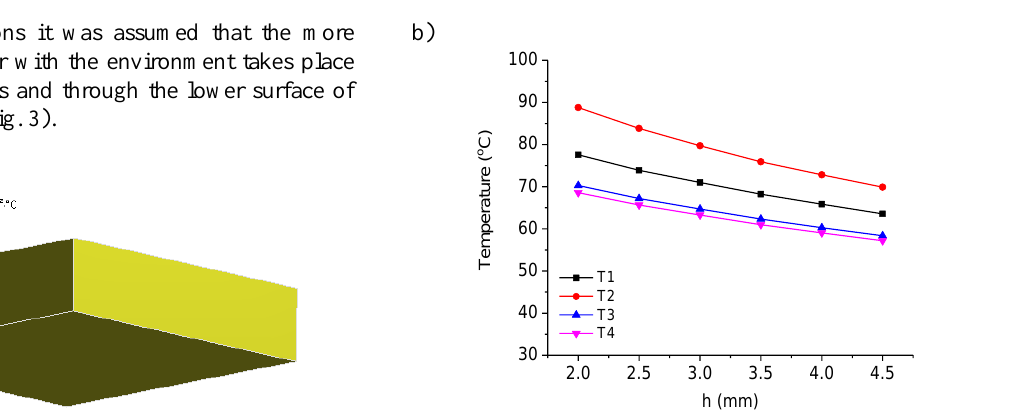
Fig. 3. Convection boundary conditions.